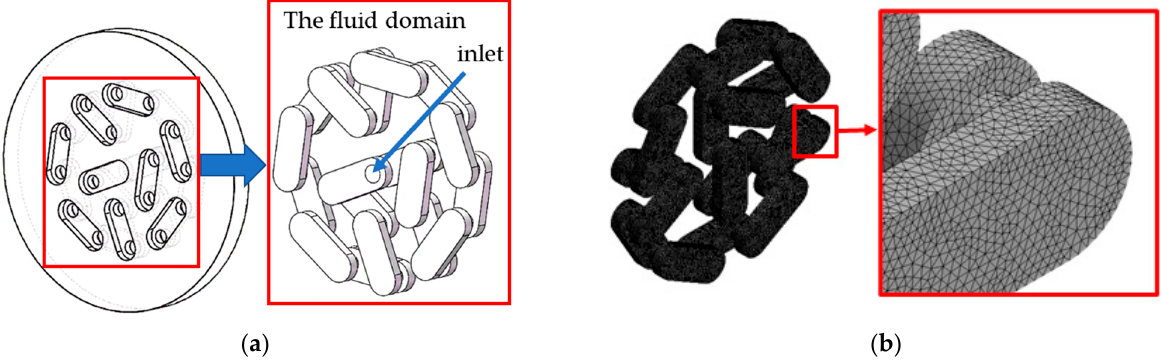
Figure 5. Steady flow plate structure and grid: ( a ) Steady flow plate structure; ( b ) Meshing results of steady flow plate.